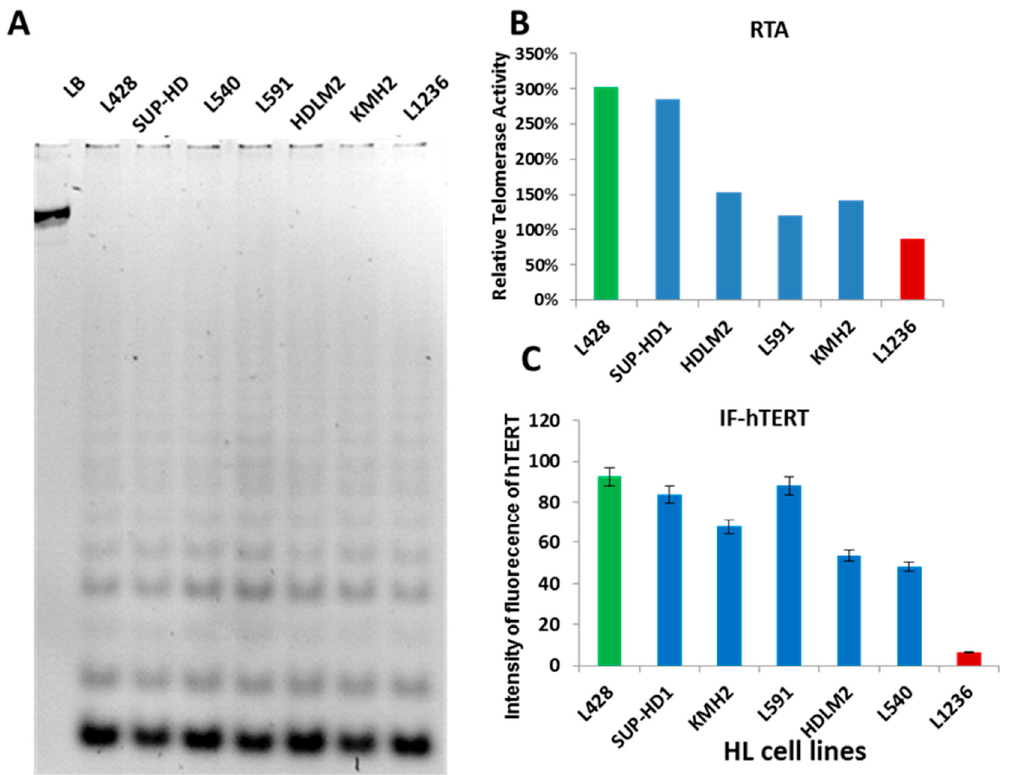
Figure 1. Telomerase expression in Hodgkin lynphoma (HL) cell lines. ( A ) PCR-based telomere repeat amplification protocol (TRAP) assay to determine the presence of telomerase activity (TA) in HL cell-lines. A lysis buffer (LB) serves as an internal control for the amplification, excluding false negatives. All HL cell lines expressed TA. ( B ) Histogram displaying the fold change of relative telomerase activity (RTA) in HL cell lines compared to CT high (positive control equal to 100%). ( C ) Quantification of the intensity of fluorecence of hTERT protein by imunofluorescence; 10,000 cells were scored. All data are representative of three independent experiments and expressed as the mean ± standard error of the mean. The experiments were performed in